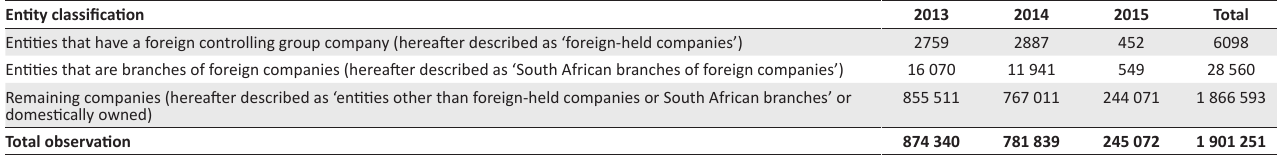
TABLE 1: Classification of observations submitted using ITR14 returns. Entity